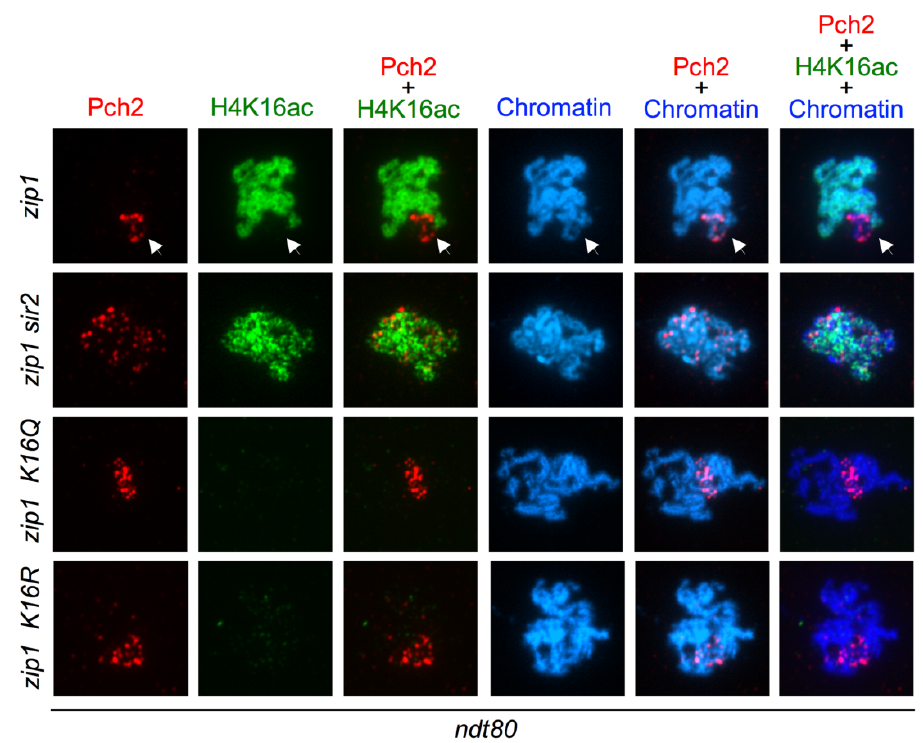
FIGURE 8: Analysis of Pch2